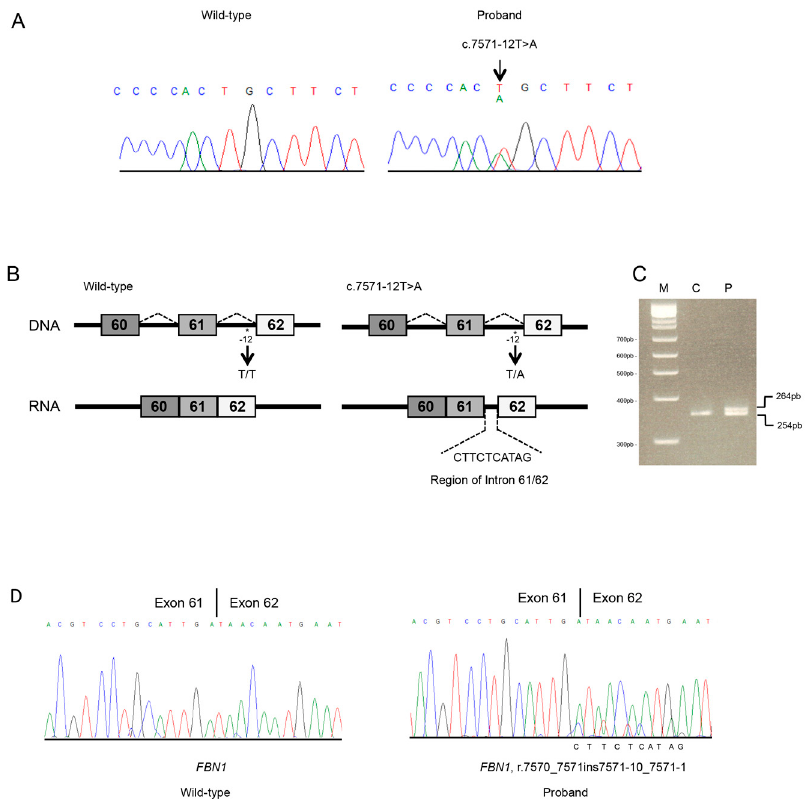
Figure 3. Molecular analyses of individual 2. ( A ) Sanger sequencing in an una ff ected (unrelated) control and the proband of the FBN1 region spanning 61 to 62 exon–intron junction. The FBN1 genomic variant is indicated by an arrow. ( B ) S chematic representation of FBN1 region including 61 to 62 exons and introns. Rectangles represent exons; thin horizontal lines represent introns. The position of the identified variant is indicated with an asterisk. Abnormal transcripts generated by the c.7571-12T > A splicing variant. ( C ) Total RNA of a normal (unrelated) control and the proband were used for RT-PCR of the FBN1 transcript. The same amounts of patient and control cDNA were PCR amplified. PCR products were analyzed by electrophoresis on 3.5% agarose gel. M, DNA marker; C, control; P, the proband. M, DNA marker; C, control; P, proband; F, father. A ff ected individual (lane P) presents both wild-type (lower band) and aberrant transcript (upper band). ( D ) Sanger sequencing of the FBN1 transcript, including exons 61 to 62 in an una ff ected (unrelated) control (C) and the proband (P). Variant position on mRNA level was annotated (r.7570_7571ins7571-10_7571-1). The intronic region was reported at the bottom of the Sanger chromatogram of the a ff ected